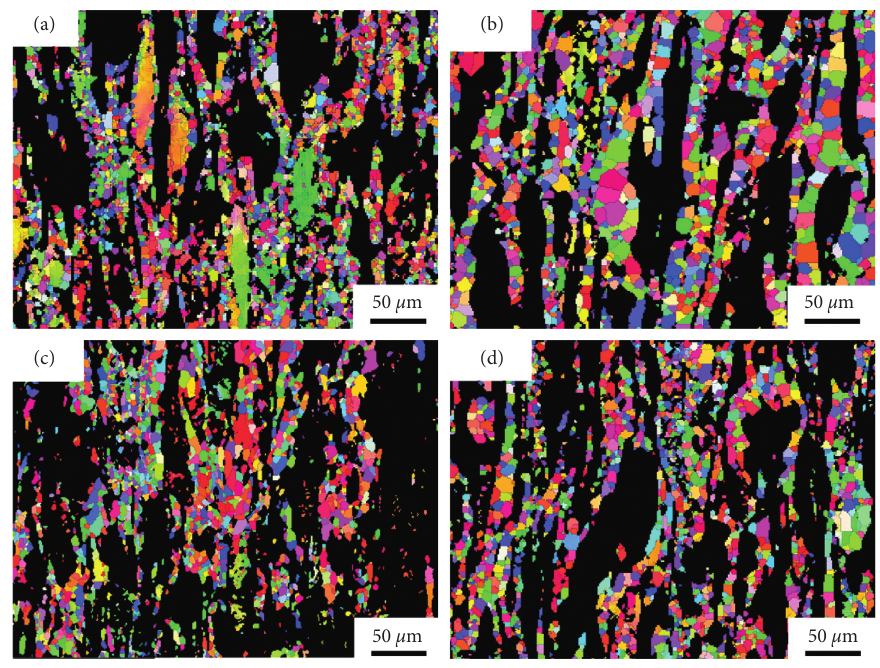
Figure 7: IPF maps of (a) MYZ, (b) MYZC, (c) MYZN, and (d) MYZCN extruded alloys.